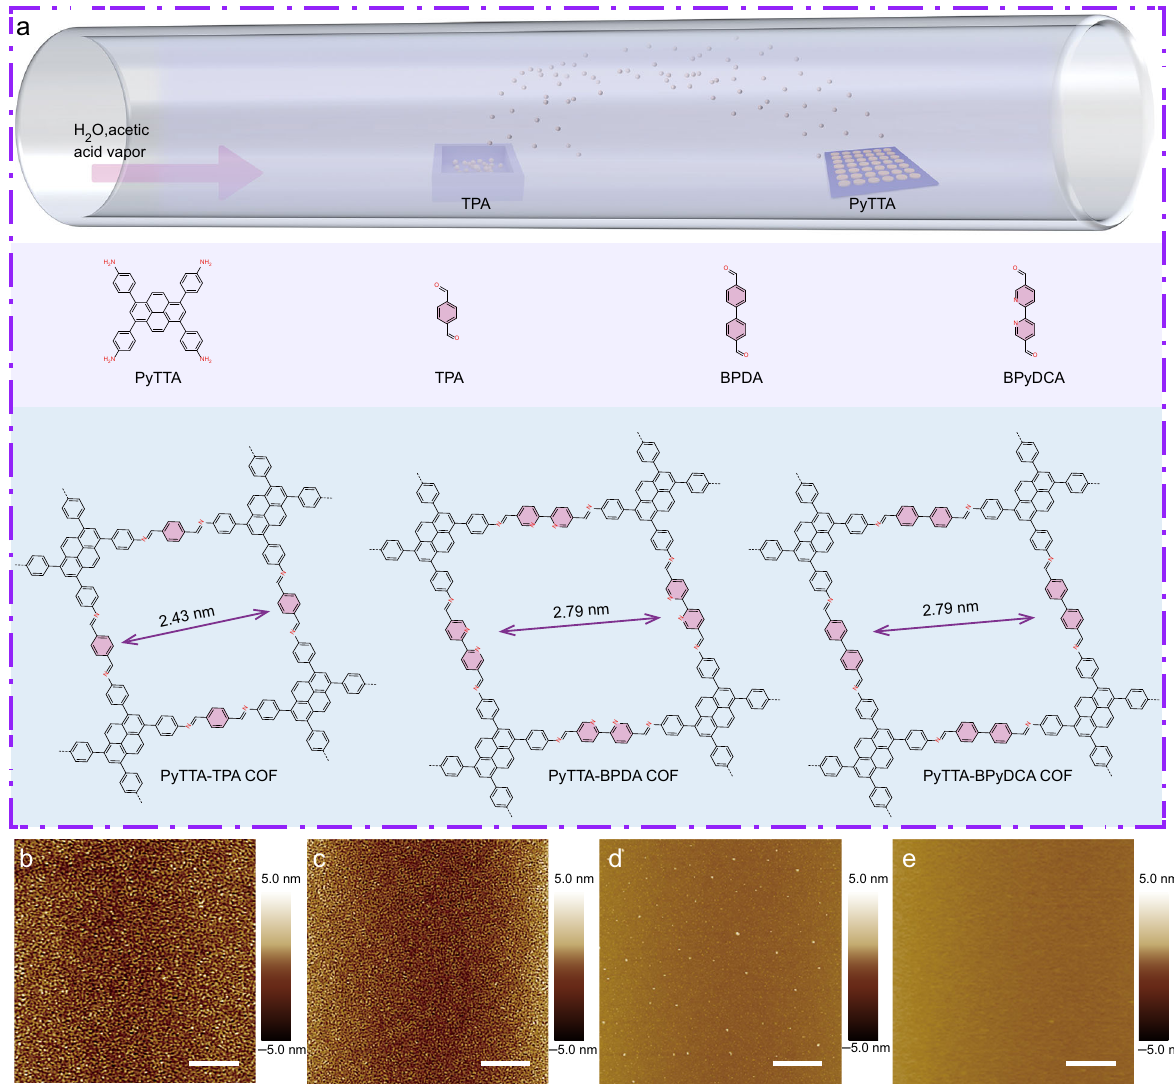
Fig. 1 Growth and structure. a Schematic representation for the growth of imine-linked 2D COF fi lms on SiO 2 /Si substrates. b AFM image of a 7-nm-thick PyTTA fi lm prepared by thermal evaporation. The average roughness ( R a ) is 1.96 nm. c – e AFM images of PyTTA-TPA COF fi lms grown at different growth times. c 7 h, R a = 1.53 nm. d 14 h, R a = 0.97 nm, e 15 h, R a = 0.73 nm, Scale bar 2 μ